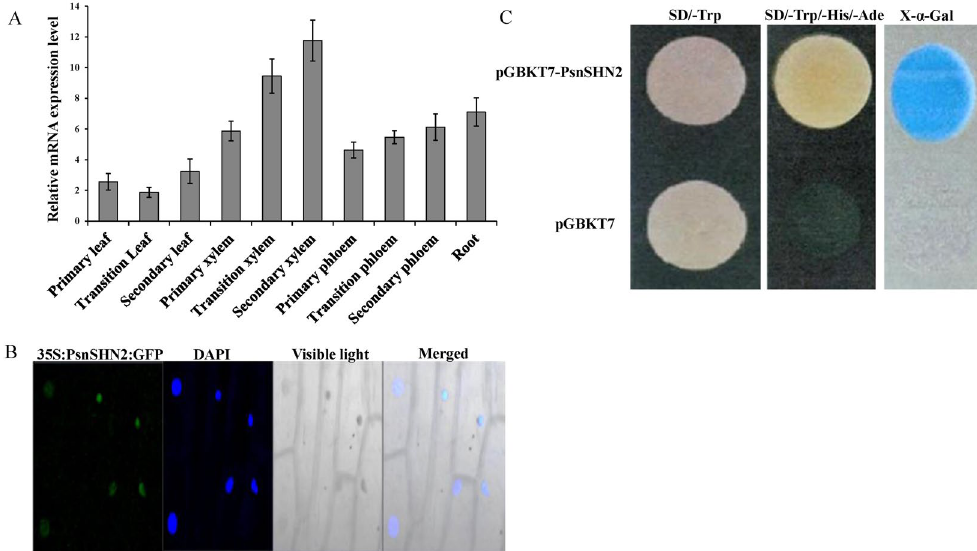
Figure 2. Expression patterns, subcellular localization and transcriptional activity of PsnSHN2 . ( A ) qRT-PCR analysis of the expression levels of PsnSHN2 in different poplar tissues. Actin was used as a control. Error bars represent the standard deviation (SD) of three biological replicates. ( B ) Subcellular localization of PsnSHN2. Confocal images show the localization of PsnSHN2-GFP in the nuclei of onion epidermal cells. DAPI, a nuclear staining dye; Merged: The merged images of bright-field, GFP and DAPI staining. ( C ) Transcriptional activation analysis of PsnSHN2 fused with the GAL4 DNA binding domain (GAL4DB) in yeast shows its potential to activate the expression of the His-3 and X- α -Gal reporter